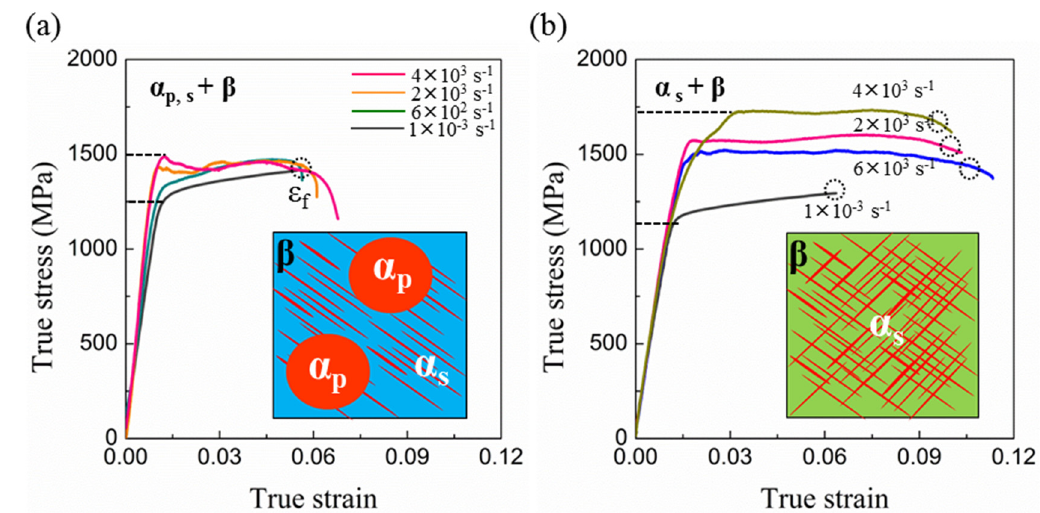
Figure 4. Mechanical behaviors of two kinds of α - β metastable β -Ti alloys at different strain rates. ( a ) Tensile stress–true strain curves of α p,s + β Ti-45551 and ( b ) tensile true stress–true strain curves of α s + β Ti-45551. The quasi-static curves (strain rate, 10 − 3 s − 1 ) were obtained from MTS testing system and dynamic curves were obtained from SHPB (strain rate ~6 × 10 2 s − 1 , 2 × 10 3 s − 1 , and 4 × 10 3 s − 1 ).